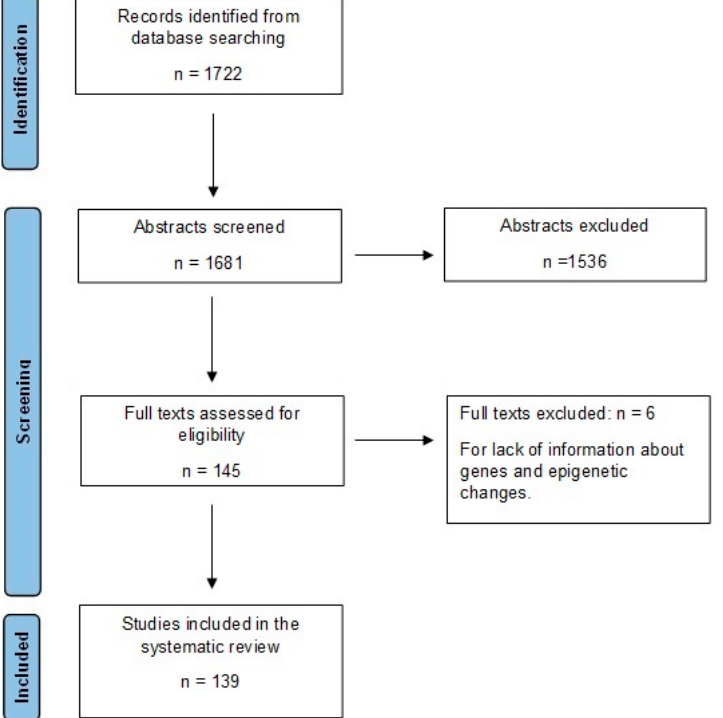
Figure 1. PRISMA (Preferred Reporting Items for Systematic Reviews and Meta-Analyses) flow diagram of the literature search and selection process for fibromyalgia, genetics, and epigenetics.